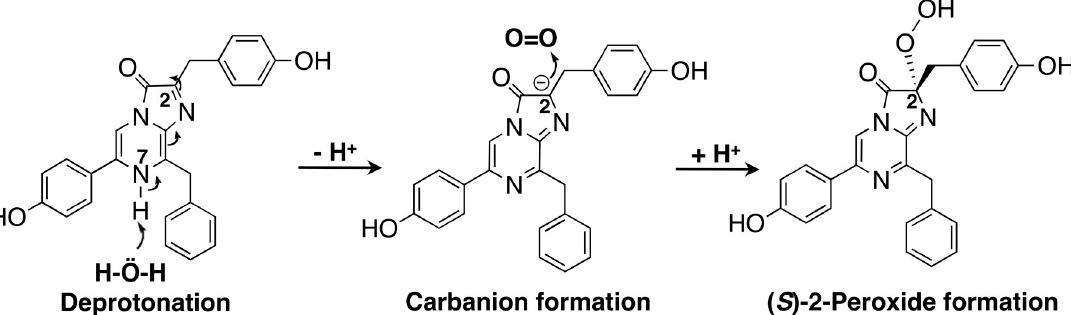
Fig 10. Proposed mechanism for the carbanion formation of coelenterazine in the regeneration process from apoAequorin, coelenterazine, and O 2